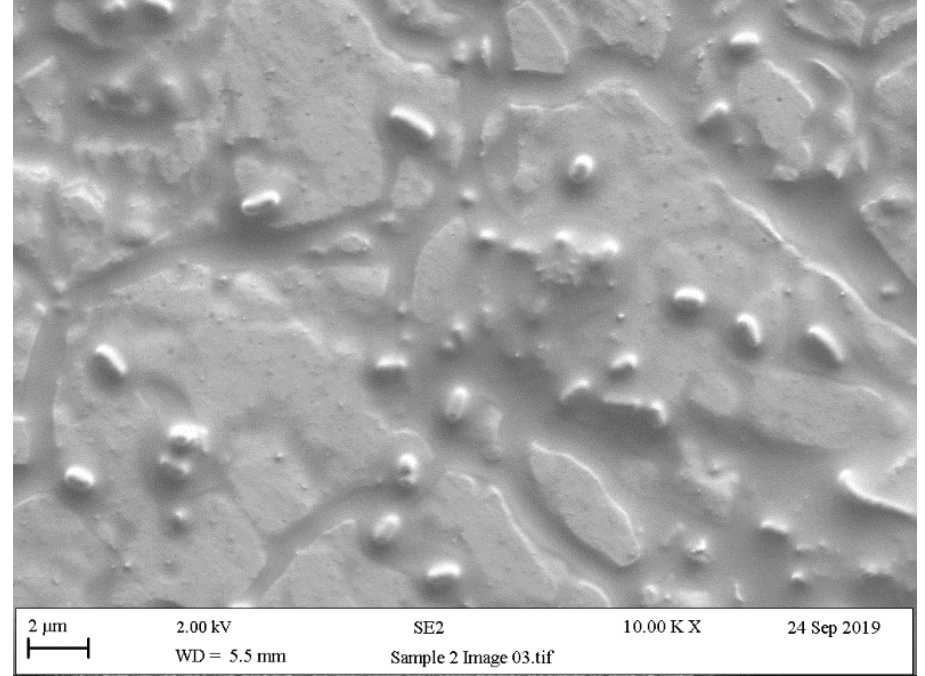
Figure 11. Scanning electronic microscopy (SEM) images of stainless steel of 7-day biofilms formed by Pseudomonas fluorescens after treatment with peracetic acid (250 ppm) for 15 min.